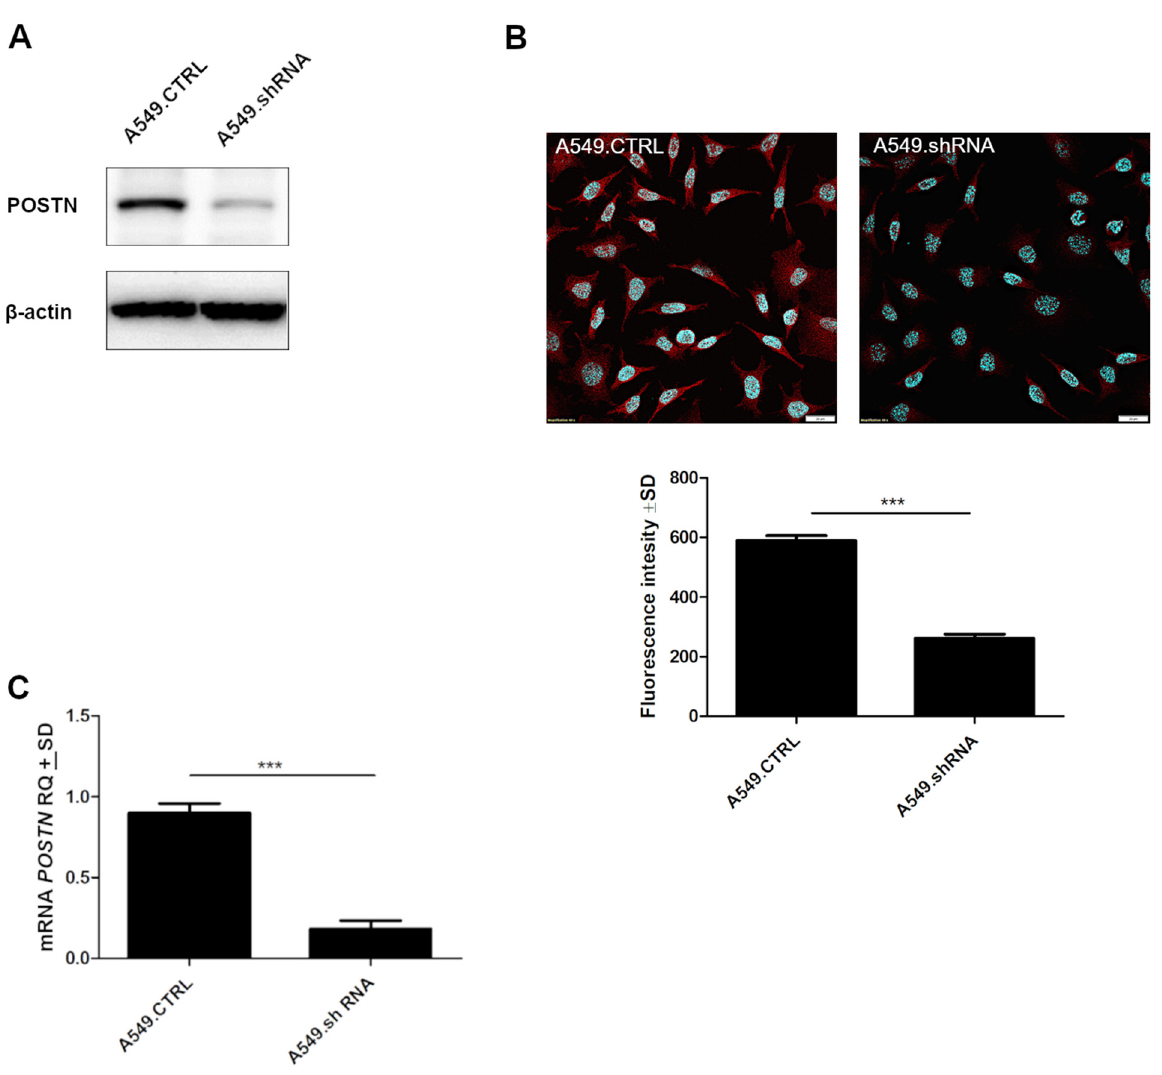
Figure 8. The efficacy of shRNA lentiviral particles transfection. ( A ) Silencing of periostin (POSTN) expression was confirmed by Western blot analysis. β -actin was used as an internal control. ( B ) Confocal images and fluorescence analysis showing the expression of POSTN in control A549.CTRL cells and A549.shRNA cells (*** p < 0.001). Objective 60×/1.40 Oil; pinhole airy 1.25. Bar = 20 µm. ( C ) The expression of POSTN mRNA in control cells (A549.CTRL) and the cells representing the loss- of-function phenotype (A549.shRNA). Relative expression (RQ) of the POSTN gene was normalized against the expression of ACTB (*** p < 0.001). RQ, relative quantification.